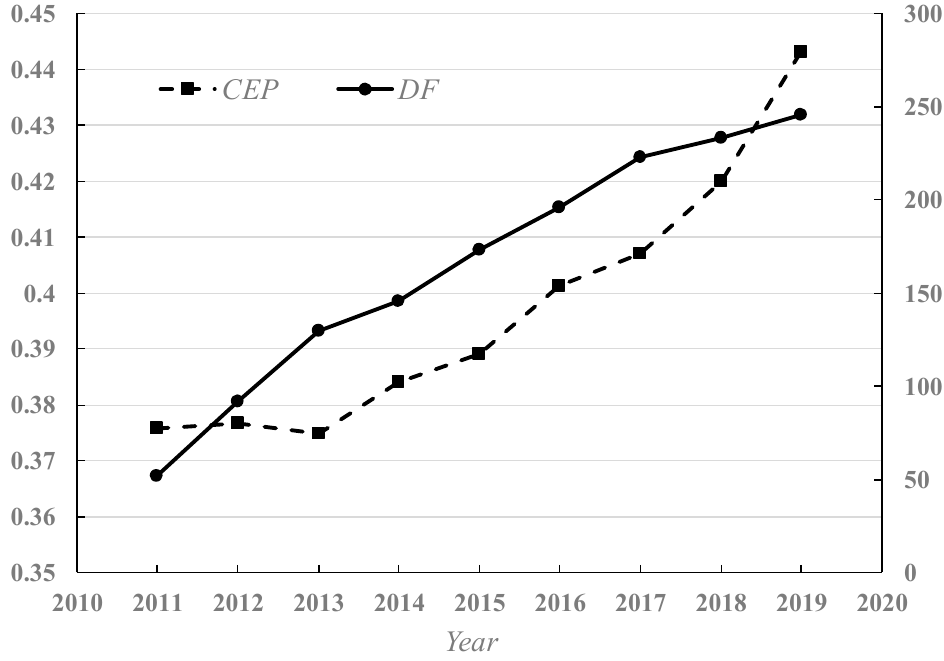
Figure 1. Average carbon emission performance and digital finance index of China’s cities from 2011 to 2019.